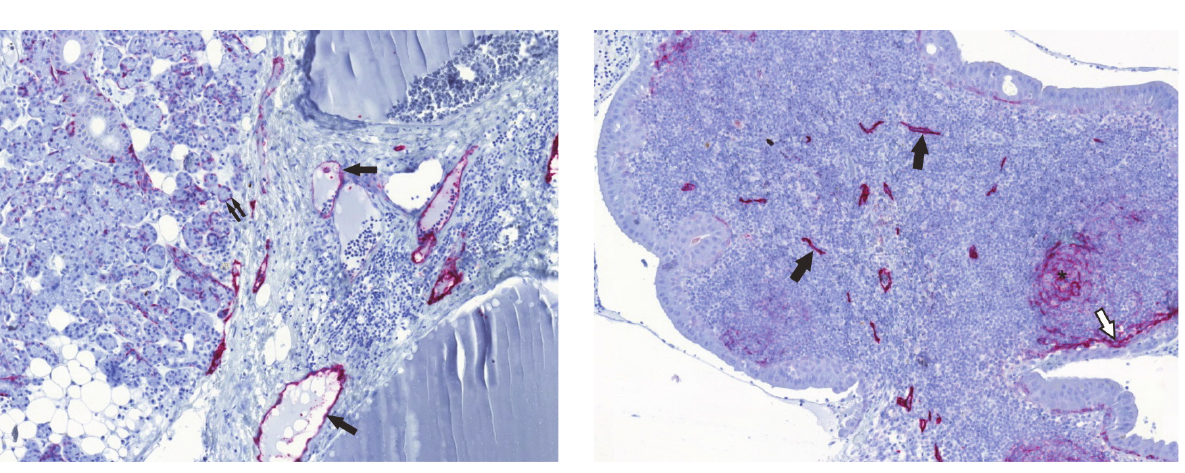
Fig. 1. Warthin’s tumour. Mostly dilated D2-40 positive lymphatic capillaries are seen in the capsule (black arrows). In the adjacent parotid paren- chyma, myoepithelial cells around ducts (white arrow) and acini (double arrow) also stain positively.